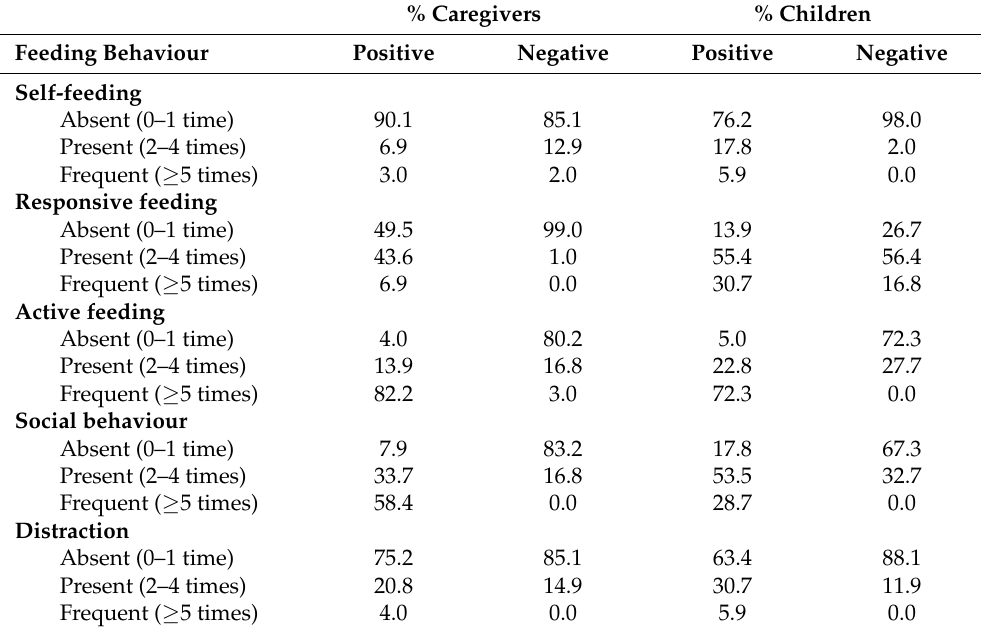
Table 4. Feeding behaviours of caregivers and children during the study meal ( n =